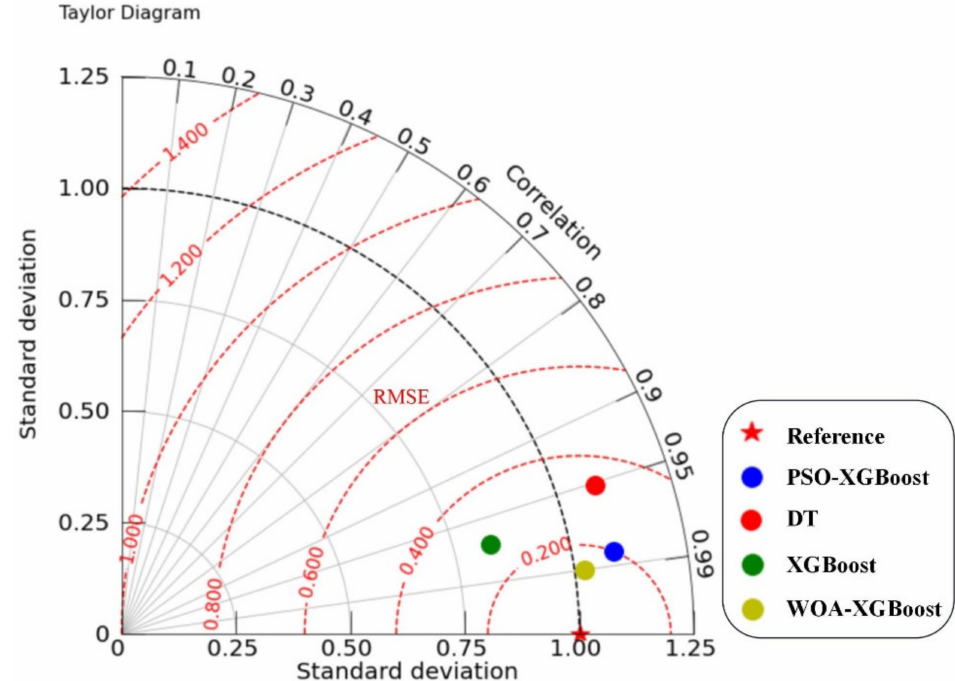
Figure 8. The evaluation indicators of different models.